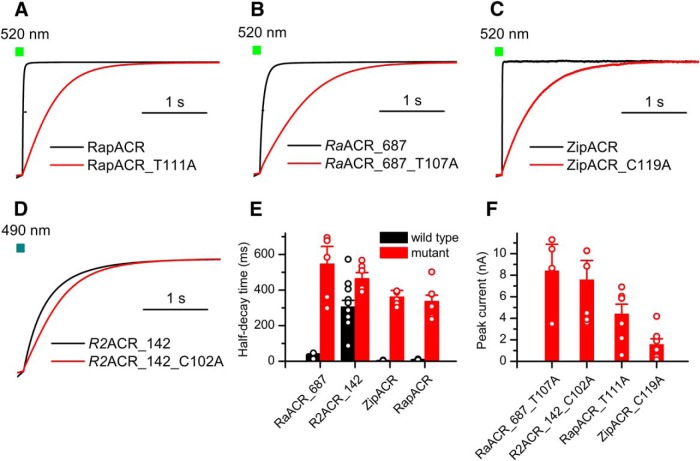
Biophysical characteristics of slow ACR mutants. A–D, Normalized photocurrent decay after 1-s illumination recorded from wild-type ACRs (black) and their respective mutants in which the residue homologous to Cys-102 (GtAR1 numbering) was mutated to Ala (red). E, F, Photocurrent half-decay times (E) and peak photocurrent amplitudes (F) measured in wild-type ACRs and their indicated mutants. The data points are mean ± SEM (n = 5–12 cells; for exact numbers, see in Table 5).